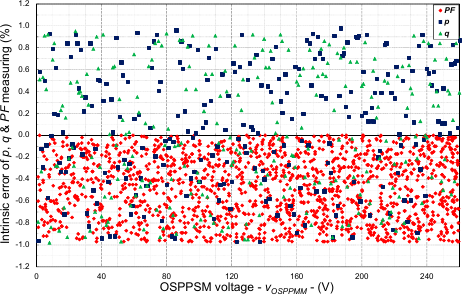
Figure 13. Voltmeter test: ( a ) OSPPSM vs. RMS voltage. ( b ) Intrinsic error of voltage measuring. Figure 14. PF meter, wattmeter, and varmeter test: intrinsic error of di ff erent variables measuring the voltage variation.